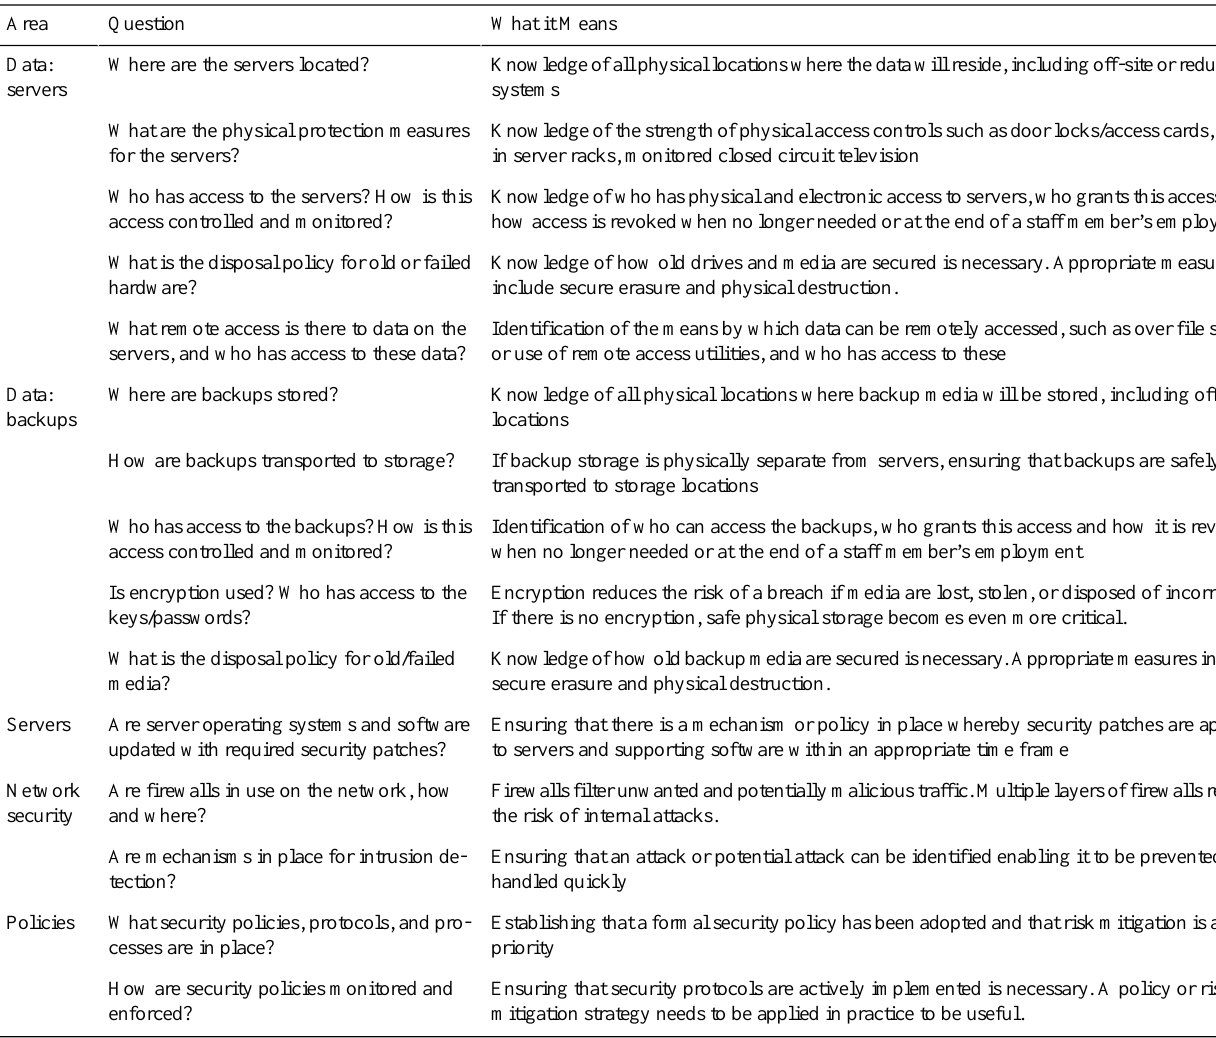
Table 1. Examples of questions that are relevant to the deployment environment